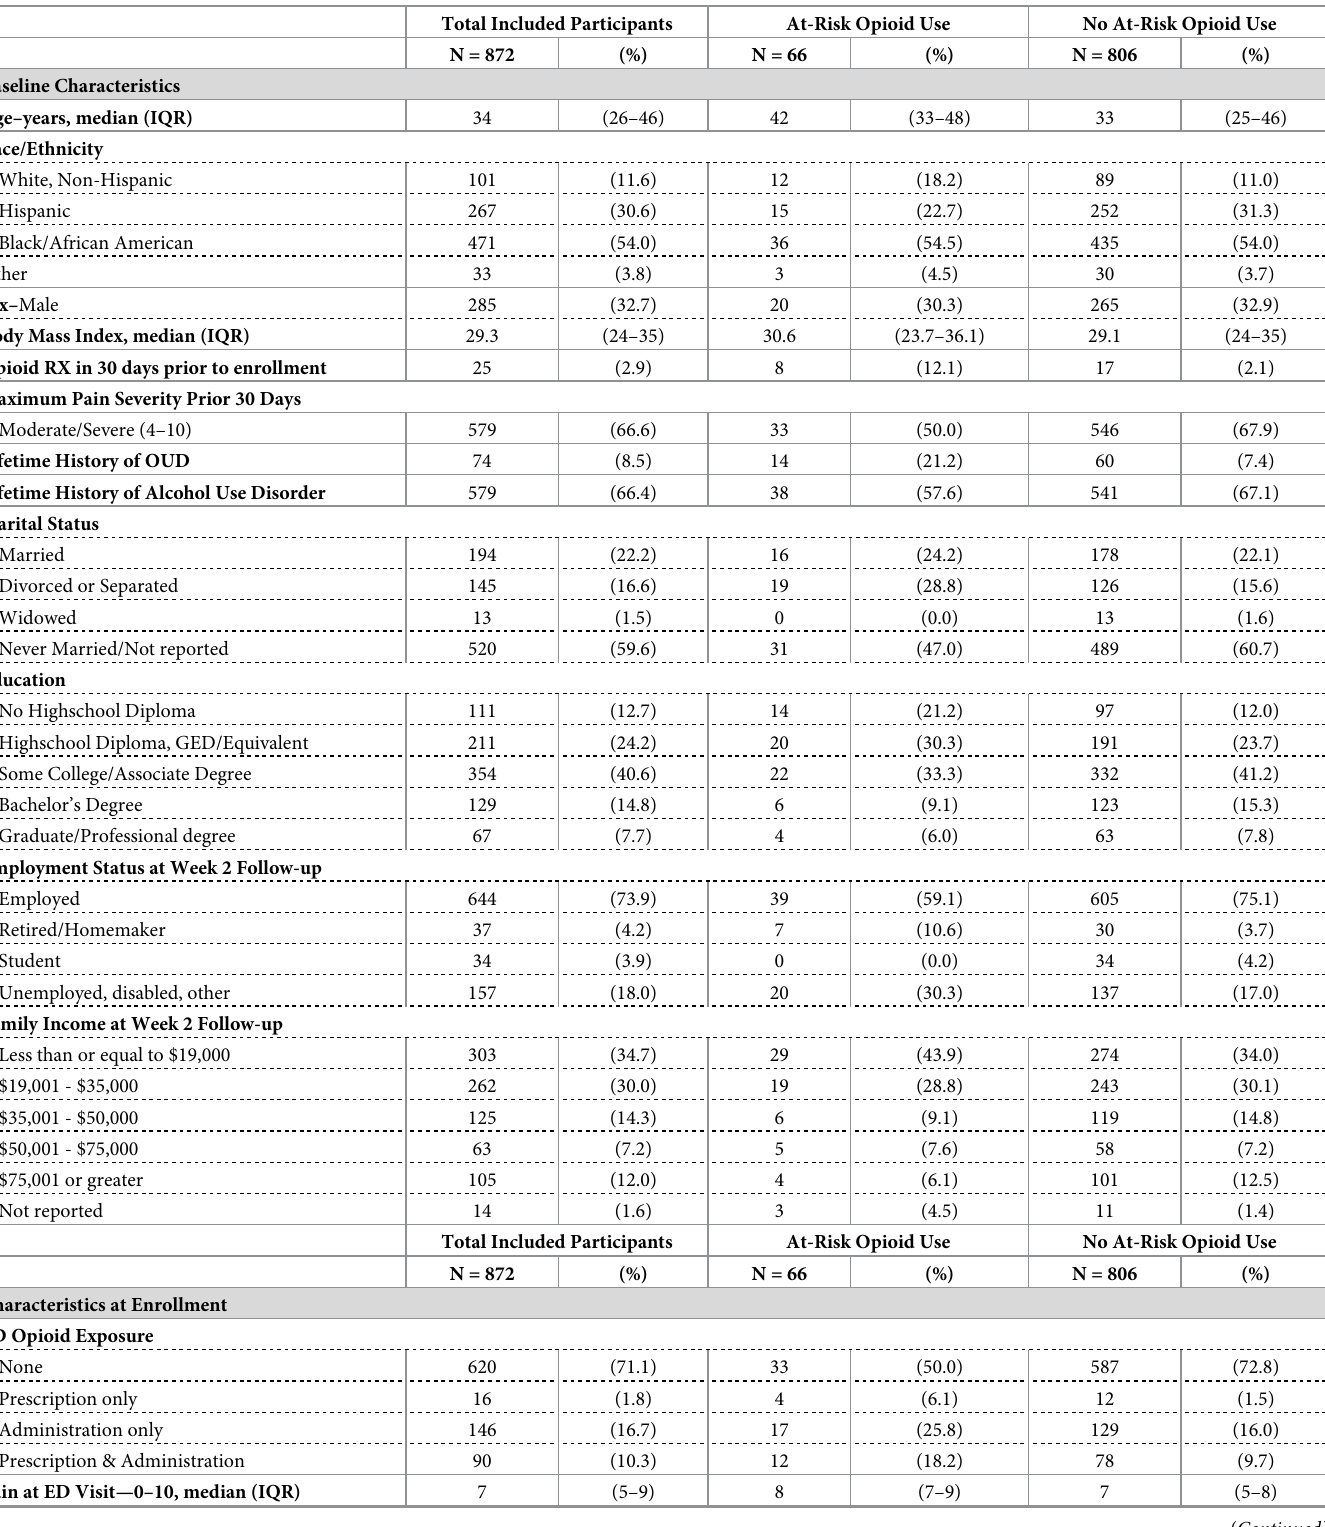
Table 1. Characteristics of study